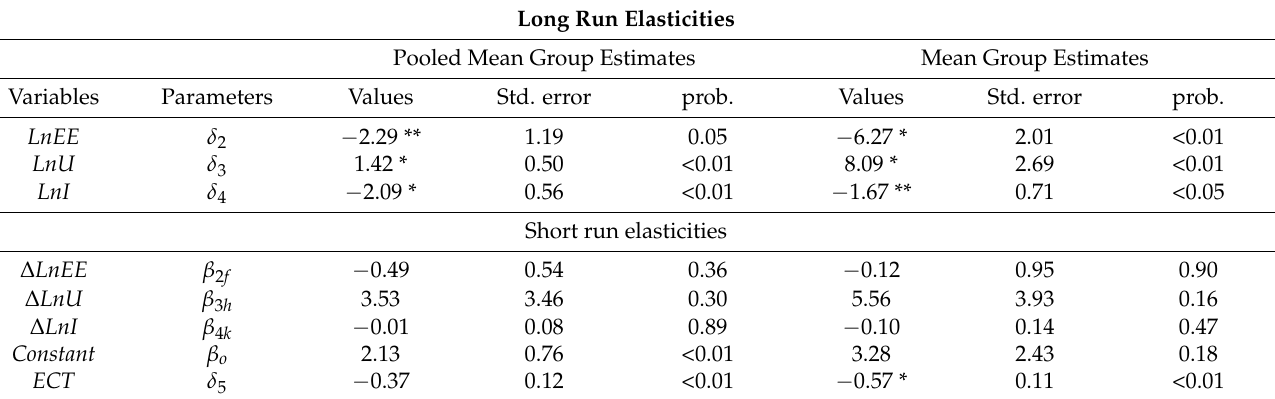
Table 7. Findings of the pooled mean group (PMG) and mean group (MG). Long Run Elasticities Pooled Mean Group Estimates Mean Group